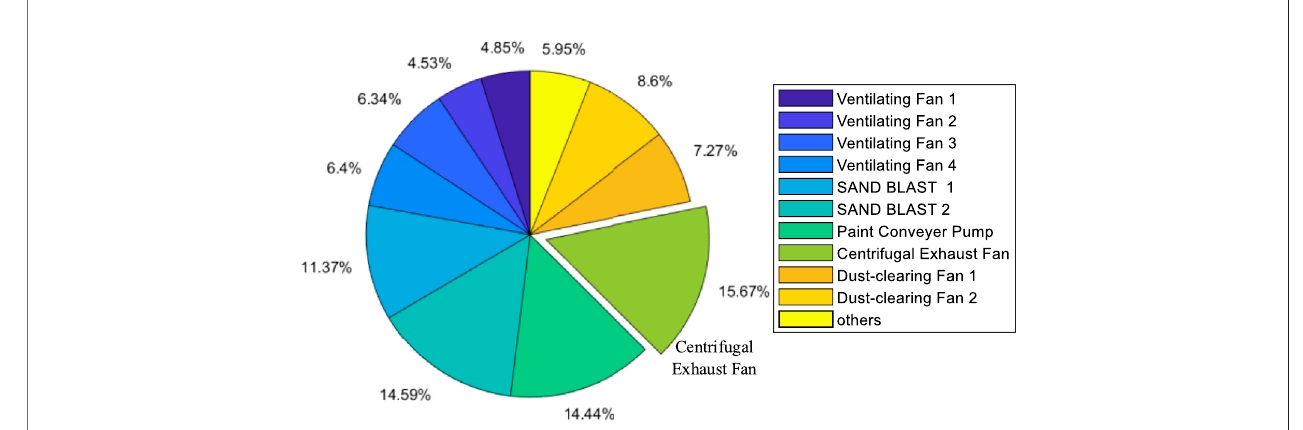
FIGURE 12 | Proportion of electricity